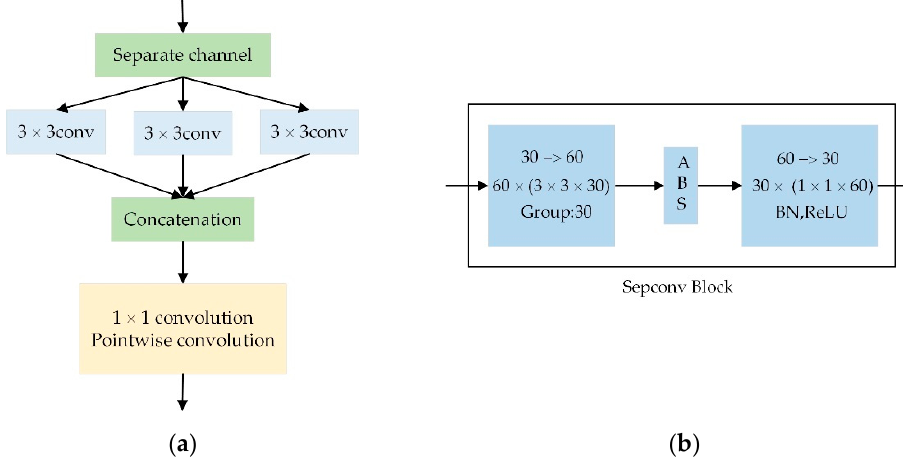
Figure 2. ( a ) Separable convolution structure; ( b ) separable convolution module.